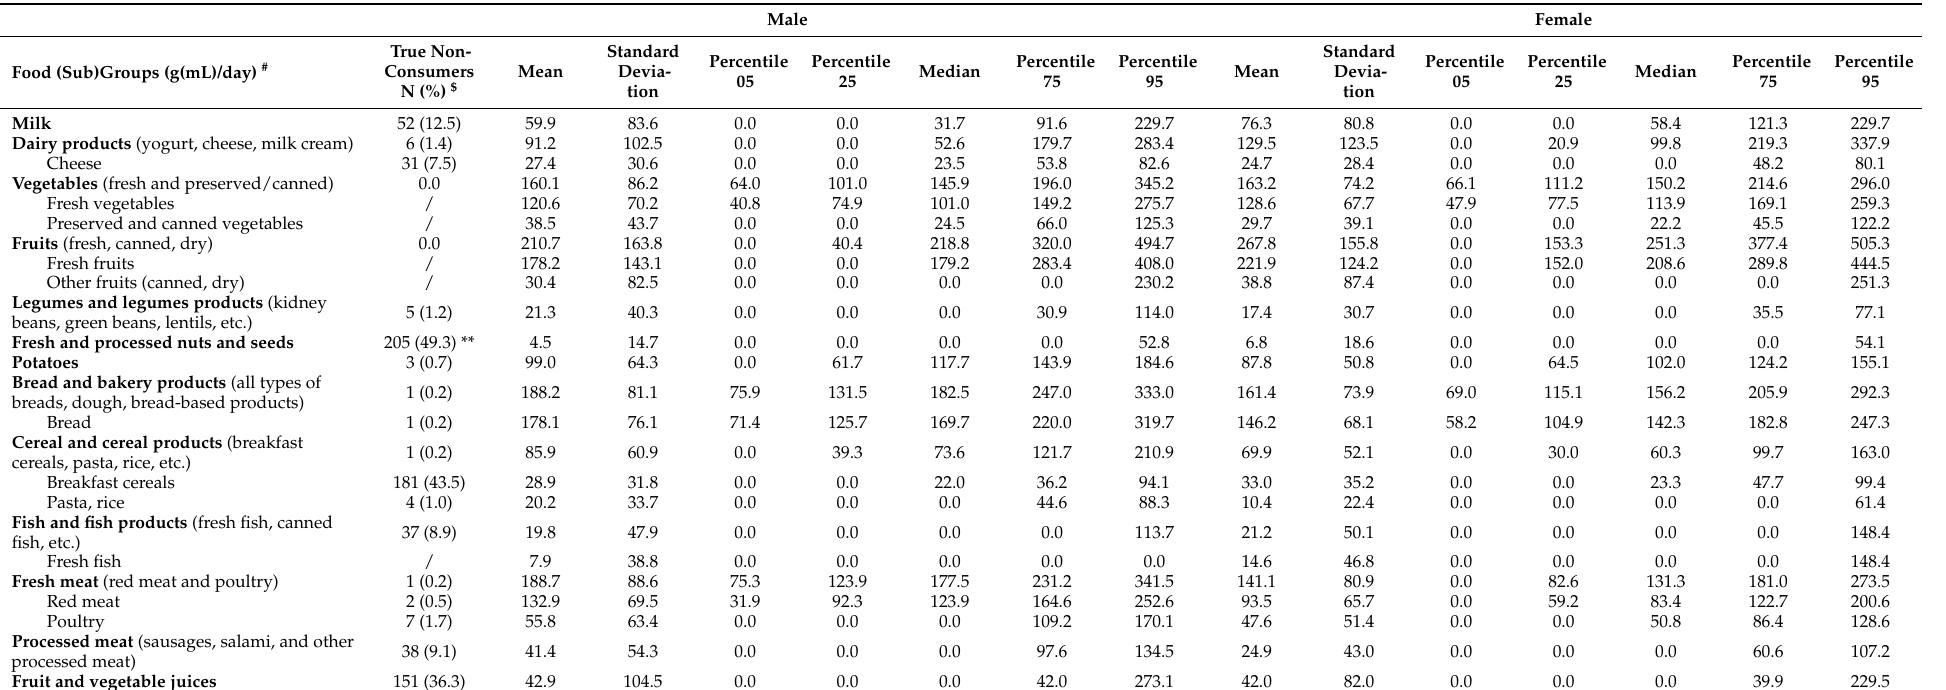
Table 3. Descriptive statistics of usual daily intakes of food groups among male and female elderlies (65–74